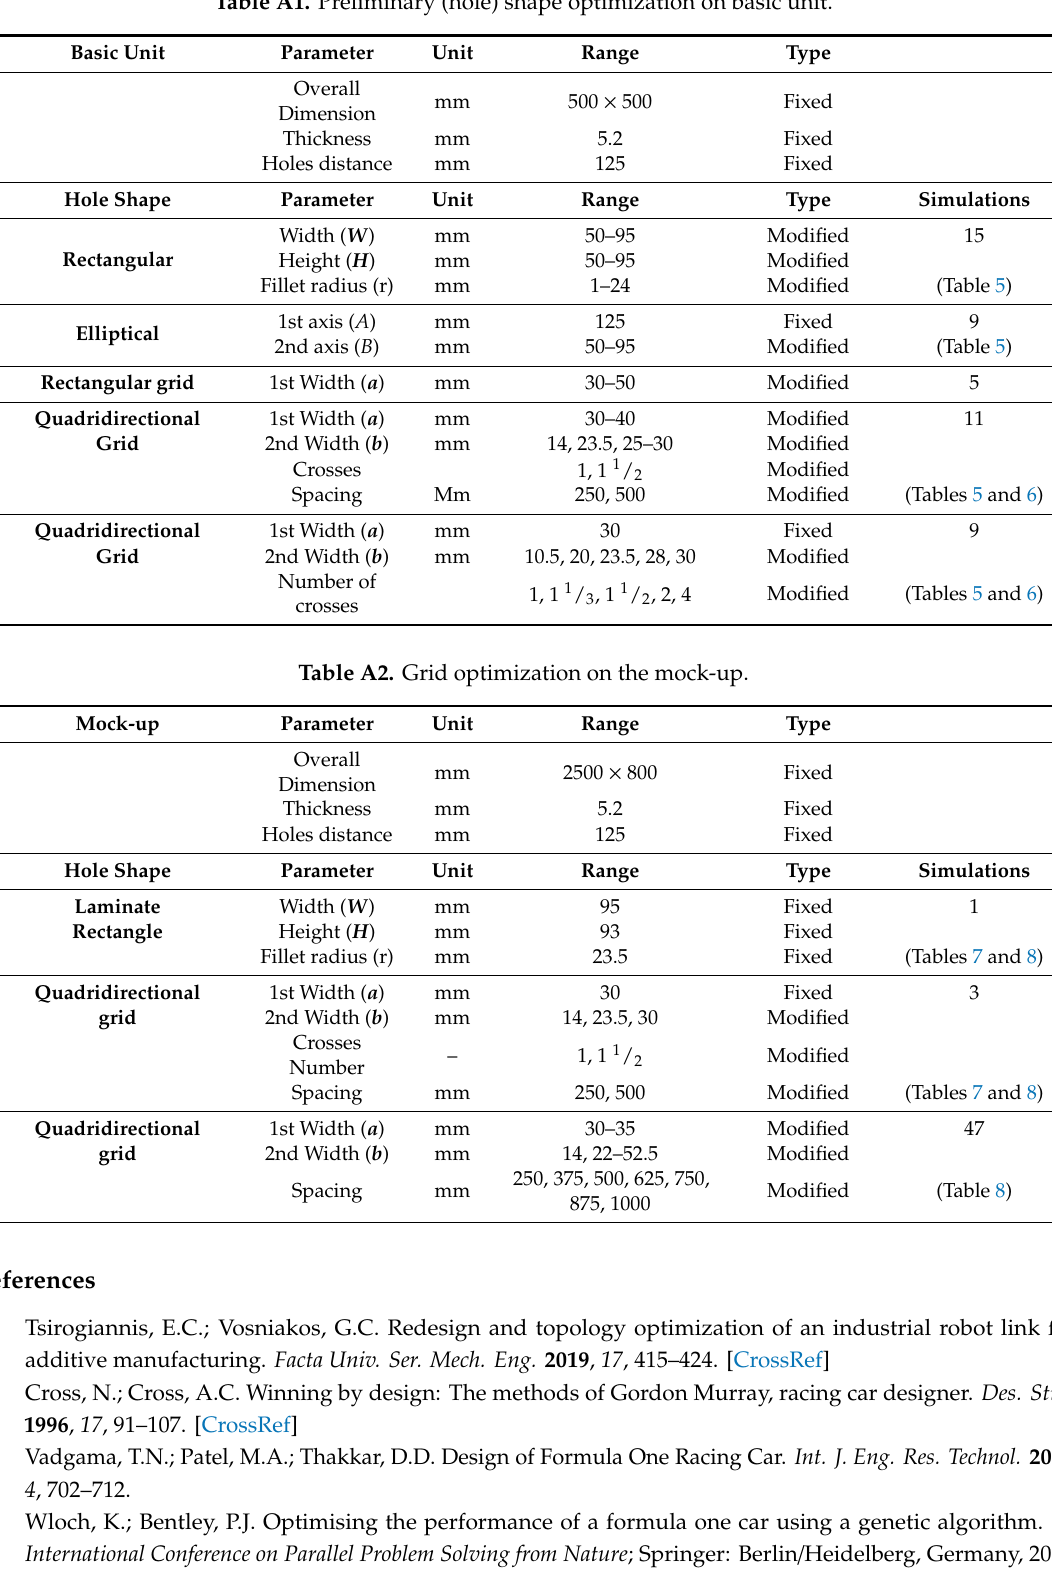
Table A1. Preliminary (hole) shape optimization on basic unit.